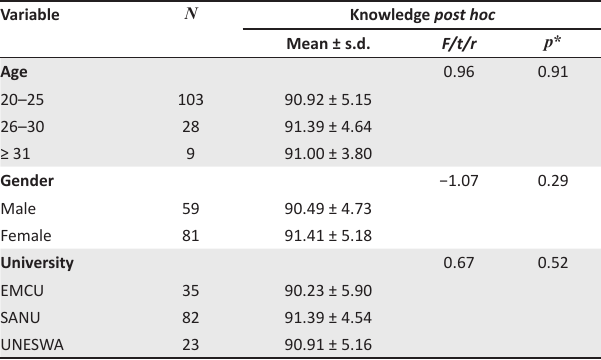
TABLE 4: Factors influencing students’ knowledge on human immunodeficiency virus and acquired immune deficiency syndrome ( n = 140). Variable